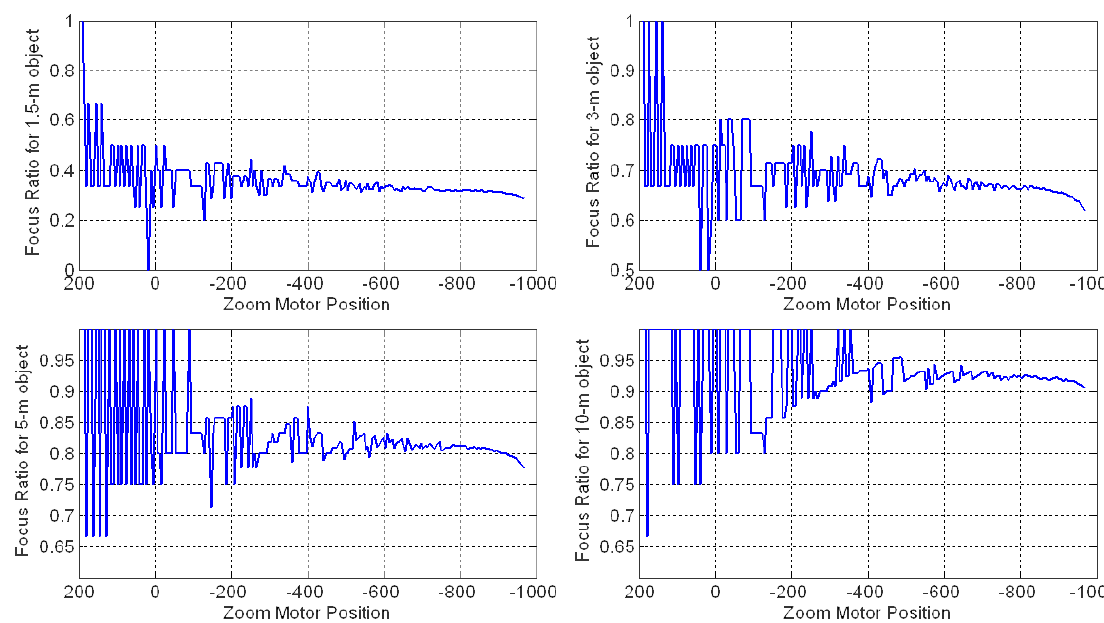
Figure 6. GZT focus ratio